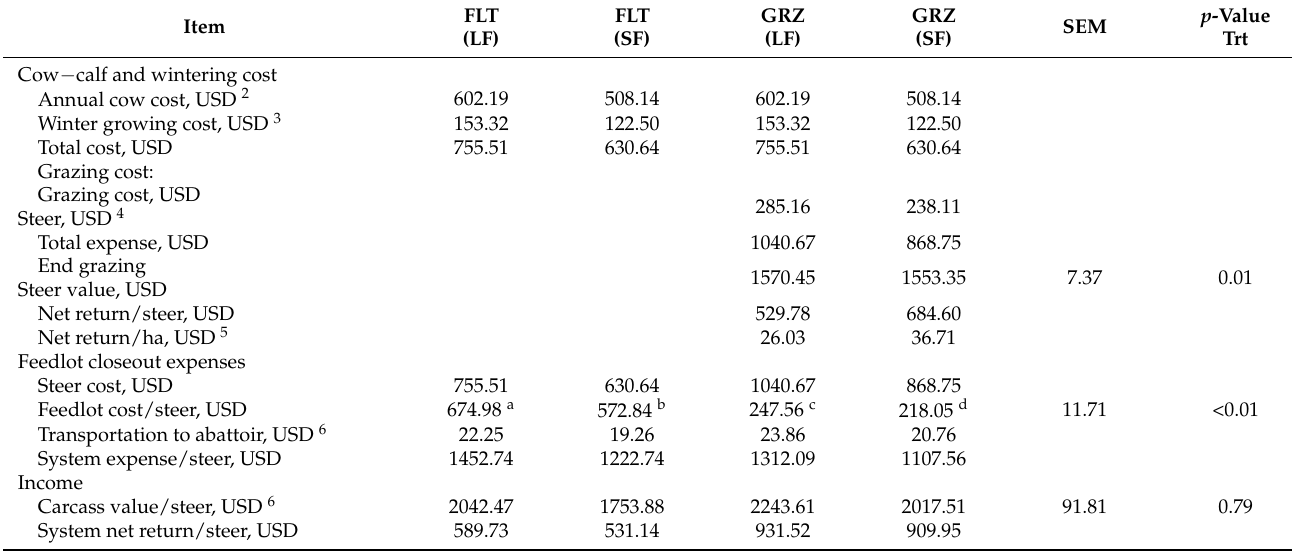
Table 8. Effect of beef steer frame score, extended grazing and retained ownership vertical integration on system net return at the end of grazing and at feedlot closeout 1